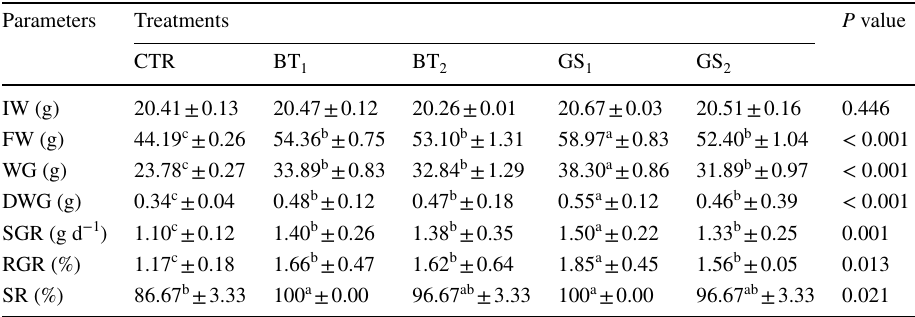
CTR, control fish group reared in clean water; BT1, fish group reared in supplemented water with B. toyonensis at level 1 × 10 5 CFU ml −1 ;